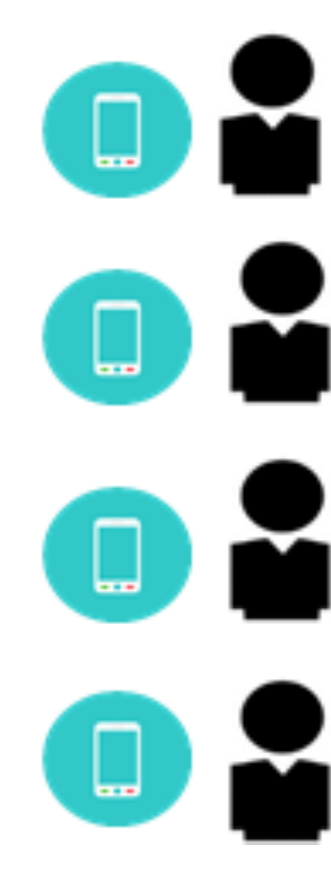
Figure 3. Hints sent by the ethics course